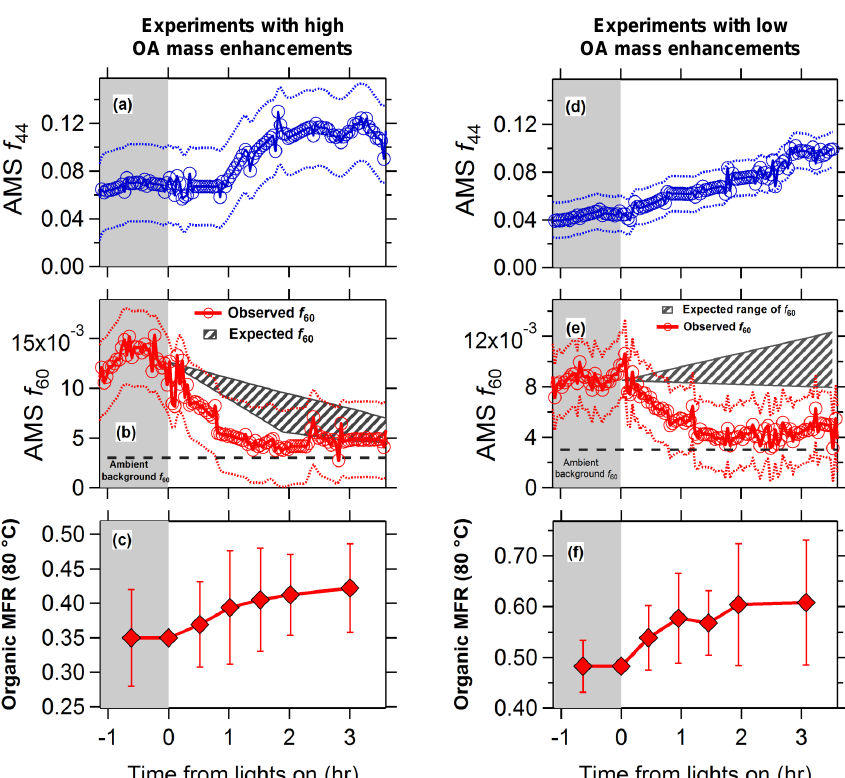
Fig. 5. Changes in chemical and physical properties of organic aerosol for the four experiments with the highest OA mass enhancement ratios (panels a – c : Burns 42, 43, 63, and 66) and the four experiments with the lowest OA mass enhancement ratios (panels d – f : Burns 40, 55, 57, and 65). (a) , (d) Changes in the fraction of the total OA mass at m/z 44 – f 44 . (b) , (e) Changes in the fraction of the total OA mass at m/z 60 – f 60 . (c) , (f) Evolution of OA volatility with time. Error bars and dotted lines represent ± 1 σ from mean.